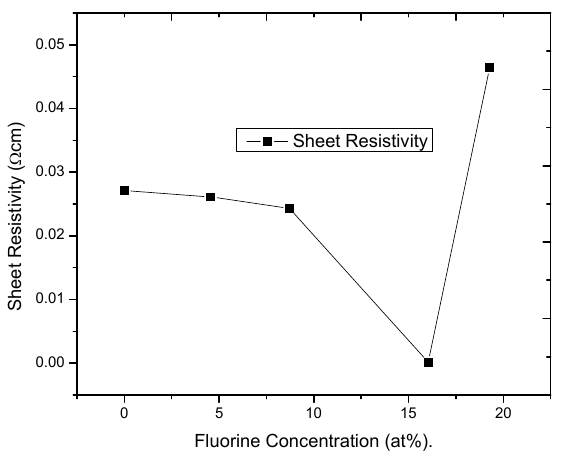
Figure 5. Sheet resistivity characteristics of Pd-F:SnO 2 .